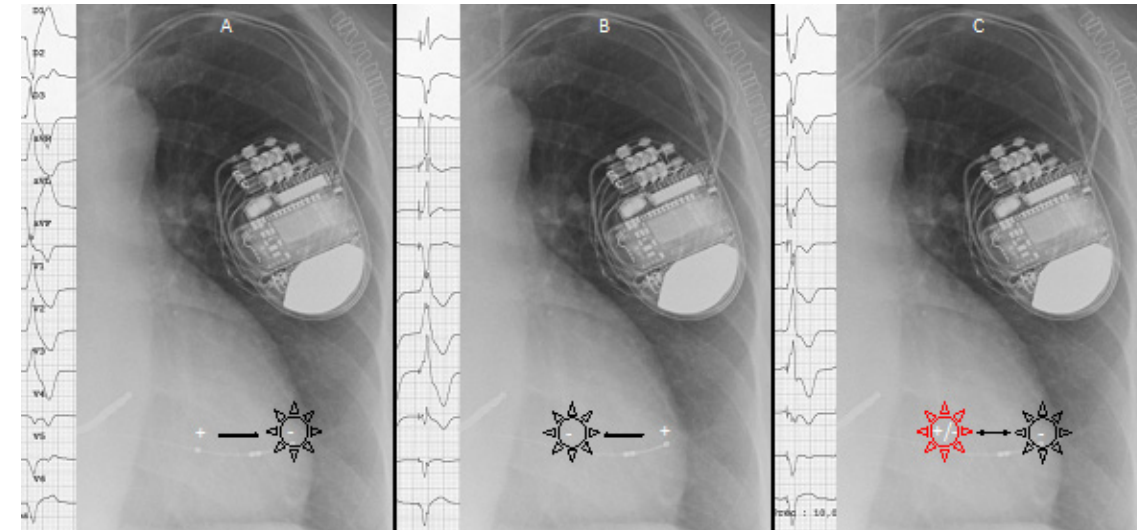
Figure 1. Intentional anodal capture during bipolar pacing by the LV quadripolar lead, so-called “pseudo-MPP”. During conventional bipolar pacing, depolarization wave front arise from the cathode ( − ) ( A , B ). When a high-density current is applied, anodal capture may be achieved, and depolarization wavefront arises from both the anode ( − ) and the cathode (+) of electrical bipole. The resulting QRS complex (left panels) is a fusion between anodal and cathodal pacing ( C ).